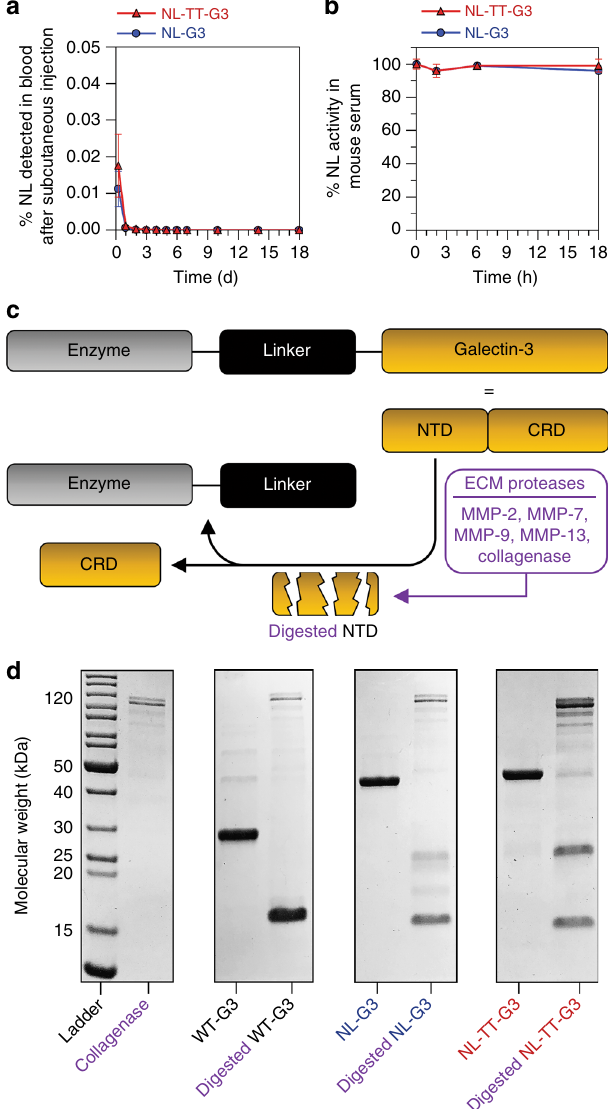
Fig. 6 Circulating concentration and proteolysis of monomeric G3 fusion proteins and trimeric nanoassemblies. a Percentage of NL, by total mass injected, in blood samples collected over time after subcutaneous injection into the hock. b Percentage of NL activity, relative to NL activity at the initial time point, in 25% mouse serum in vitro. c Schematic of ECM proteases, such as collagenase and other MMPs, digesting the N-terminal domain (NTD) of G3, thereby separating the carbohydrate-recognition domain (CRD) of G3 from the enzyme fusion partner. d SDS-PAGE analysis of collagenase-mediated digestion of WT-G3, NL-G3, and NL-TT-G3. Uncropped gel image found in Supplementary Figure 26. N = 5, mean ± s.d. for a . N = 3, mean ± s.d. for b . Data for NL-G3 appear as blue